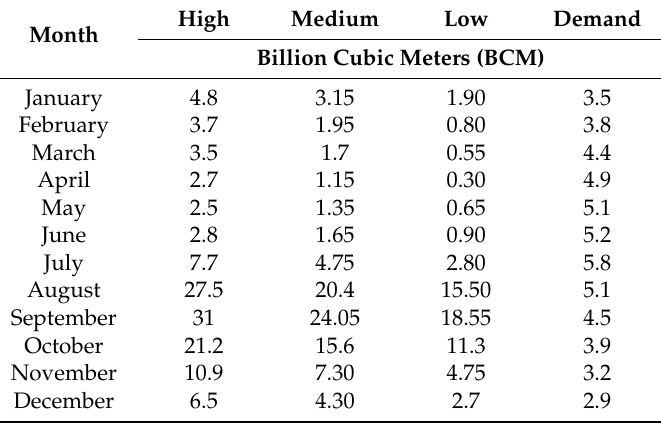
Table 1. Classification of monthly inflow to the reservoir (BCM) (1989–1999).